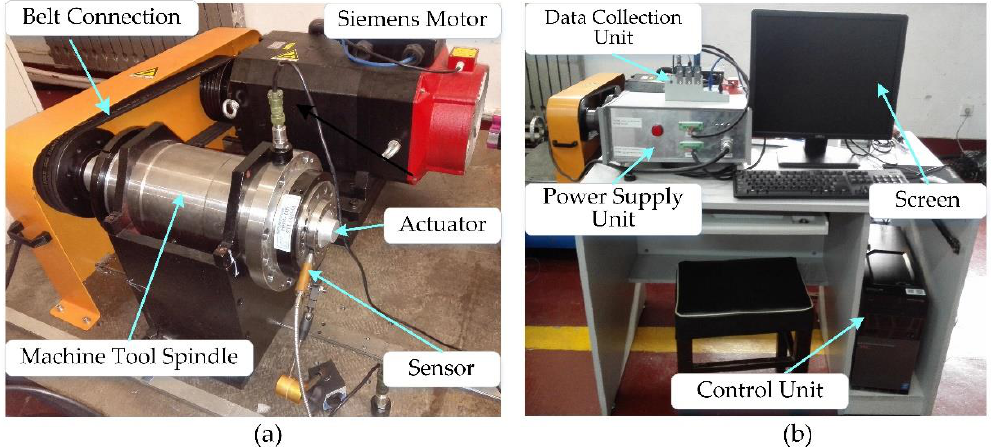
Figure 18. Overall diagram of experimental device: ( a ) Balancing actuator and the rotor system; ( b ) Other components of the balancing system.